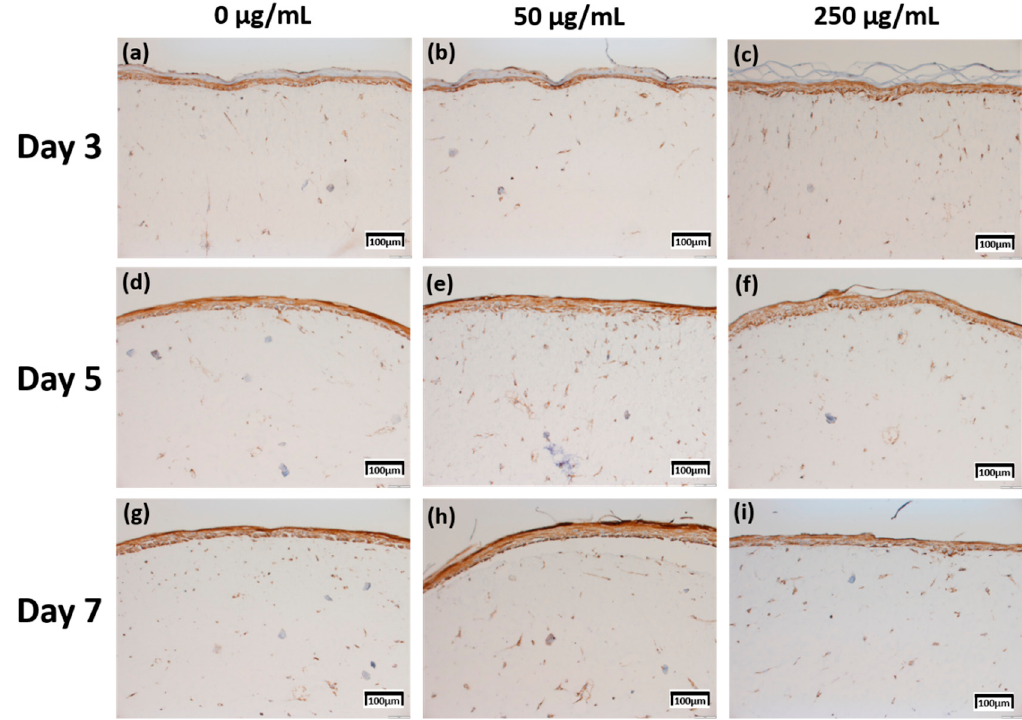
Figure 6. Immunohistochemistry stained images for involucrin of 3D cell cultured sample for 3 days air exposure using culture media-treated CLLE concentrations of ( a ) 0 μ g/mL, ( b ) 50 μ g/mL, and ( c ) 250 μ g/mL; for 5 days air exposure using culture media-treated CLLE concentrations of ( d ) 0 μ g/mL, ( e ) 50 μ g/mL, and ( f ) 250 μ g/mL; and for 7 days air exposure using culture media-treated CLLE concentrations of ( g ) 0 μ g/mL, ( h ) 50 μ g/mL, and ( i ) 250 μ g/mL.